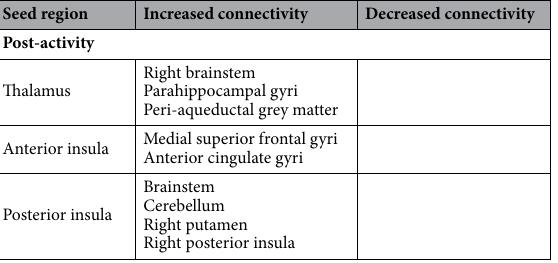
Table 3. Connectivity changes in study patients pre and post activity.